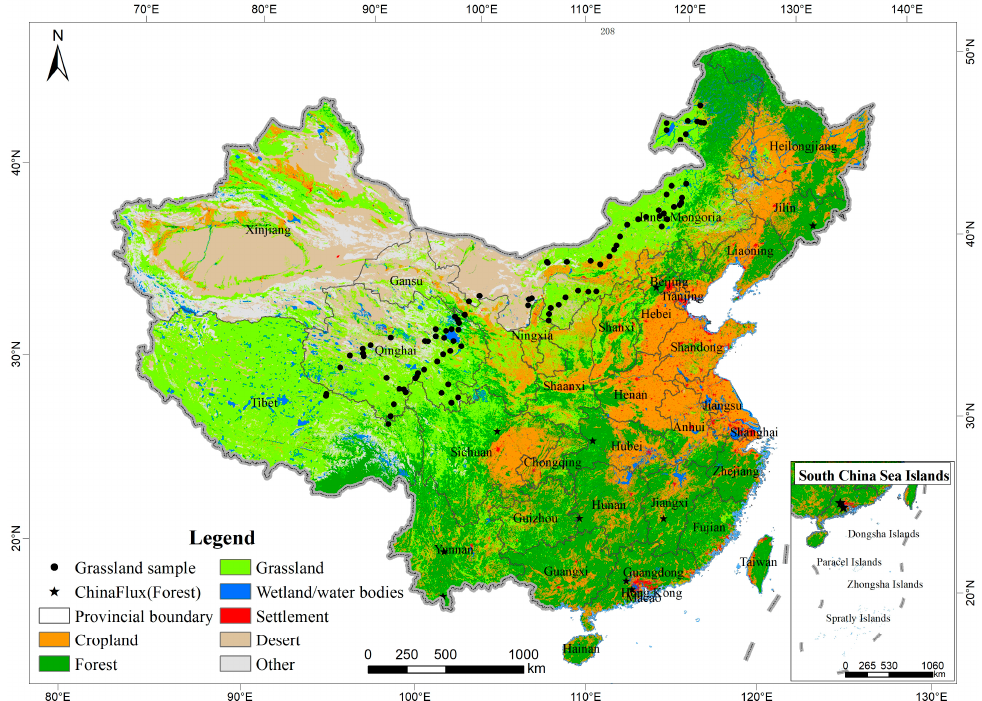
Figure 3. Spatial distribution of grassland sample plots, forest flux stations and China’s terrestrial ecosystems.